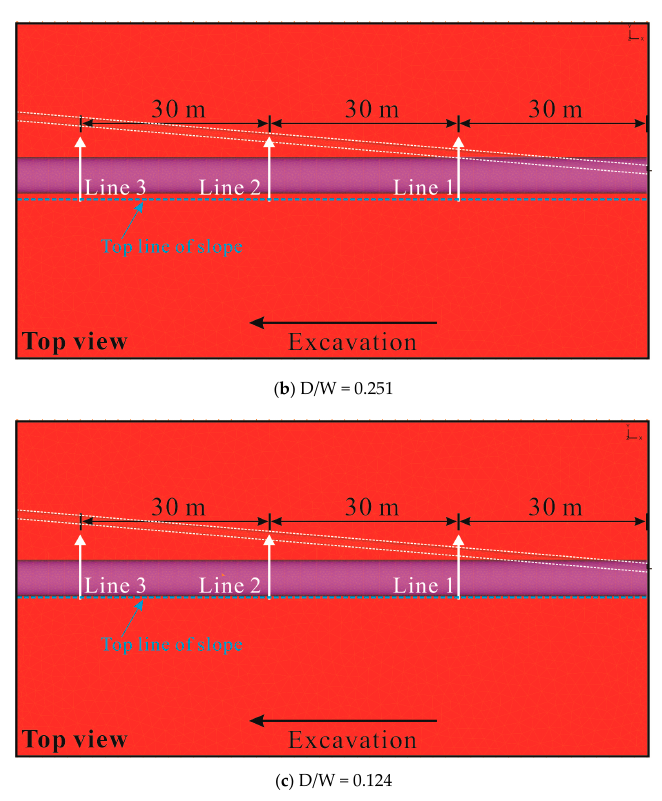
Figure 7. Schematic of data extraction locations.